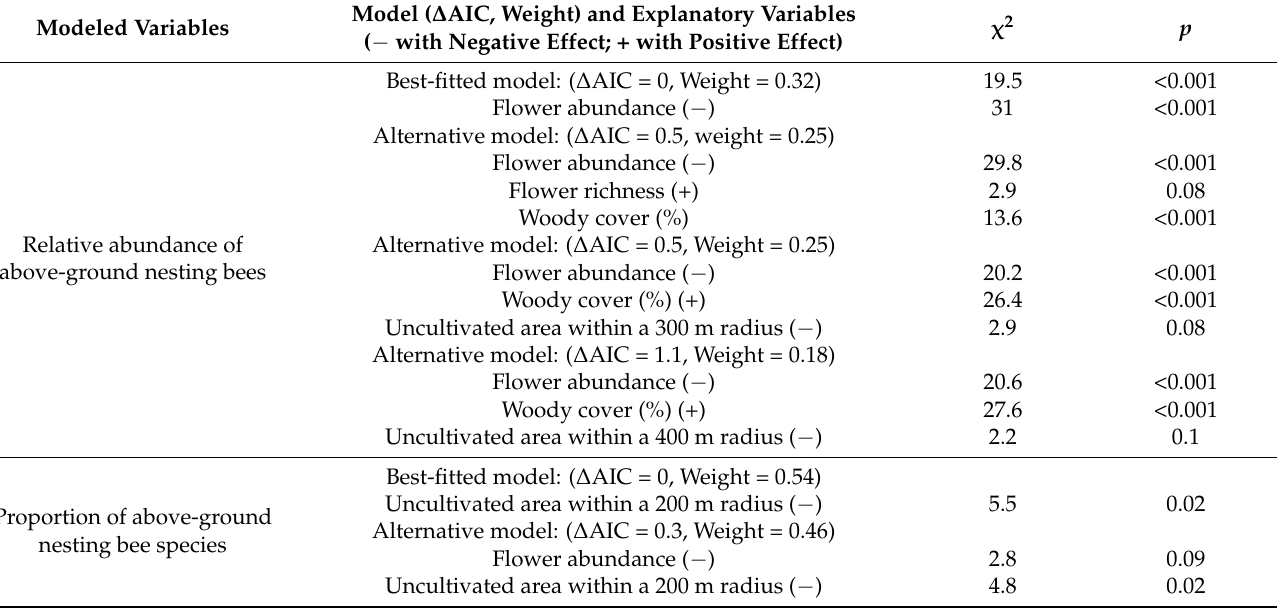
Table 2. Best-fitted GLMM models ( ∆ AIC < 2) for the proportion of above-ground nesting bees and bee